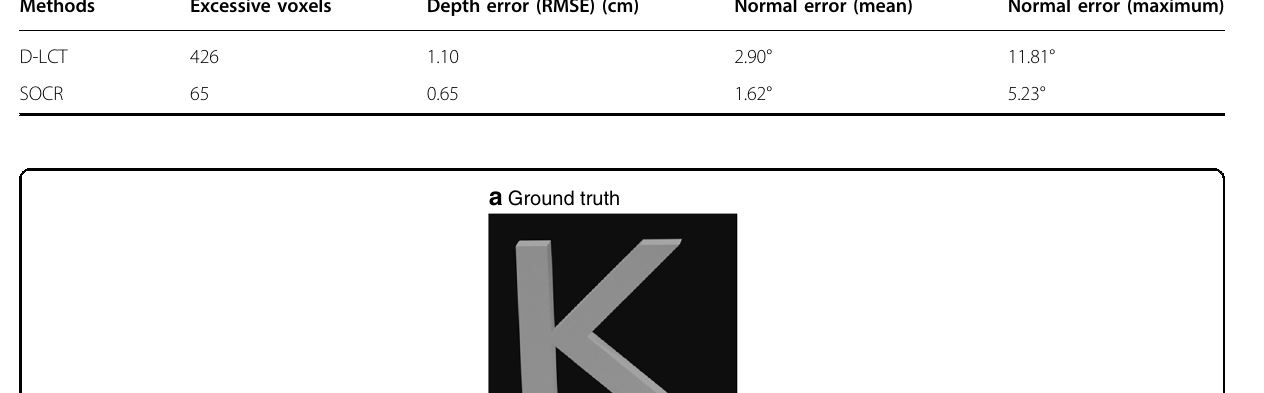
Table 2 Comparisons of the D-LCT and SOCR reconstructions of the pyramid Methods